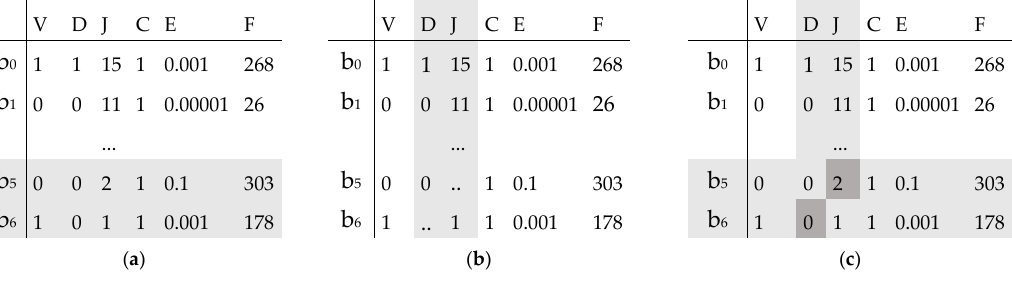
Figure 3. An example of a two-point mutation procedure, ( a ) parent (selected sub-chromosomes in grey), ( b ) clone (selected genes in grey), ( c ) mutated clone (nucleotide in grey). Table 2. The example of a chromosome generated from the DNA